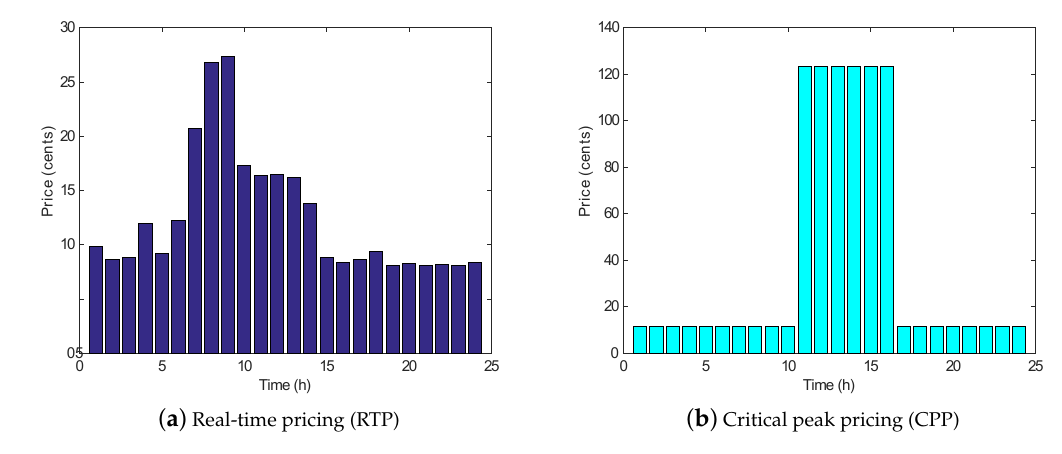
Figure 1. Proposed system model.